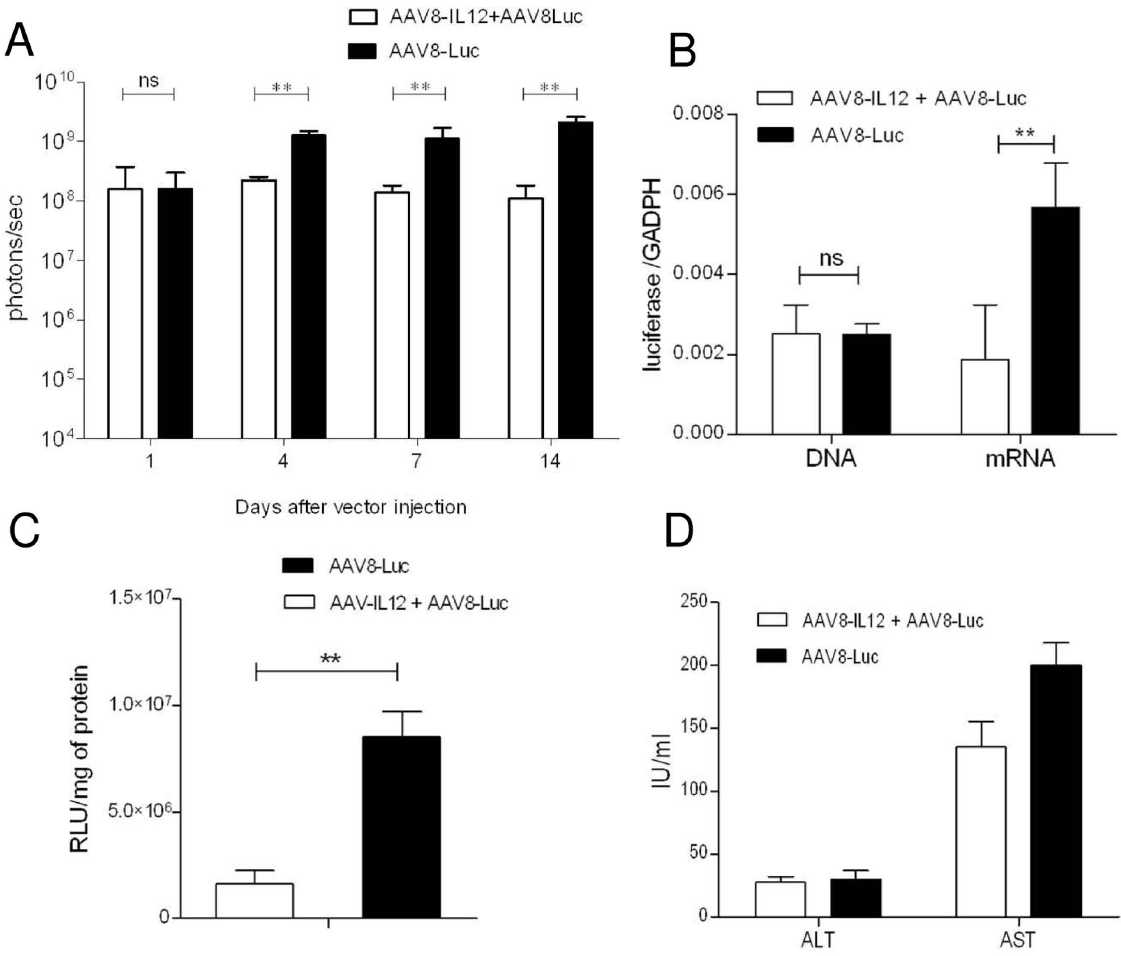
Figure 2. IL-12 down-regulates AAV mediated gene expression without reducing the number of viral genomes. C57BL/6 mice (n=5) received 2.5 6 1011 vg/kg of AAV8-luc vector alone or in combination with 1.5 6 109 vg/kg of AAV8-IL12 vector. A) Luciferase expression levels were analyzed in both groups of animals at days 1, 4, 7, and 14 using a Xenogen in vivo luminometer. Luciferase expression was quantified and represented as photons/second. The data are shown as mean 6 standard deviation (SD). The differences in luciferase expression were statistically evaluated by Student t test (**p , 0.01). B) Animals were sacrificed at day 14. Total DNA and RNA were isolated from liver and vector genome copies and luciferase messenger RNA (mRNA) copies were determined using a q-PCR specific for luciferase, normalized to GADPH copy numbers. Values correspond to the mean copy number from five animals. C) The levels of luciferase activity (relative light units, RLUs) were determined in liver homogenates and were normalized to protein content (RLU/mg). The data are shown as mean 6 SEM. D) Serum transaminases were analyzed 14 days after vector injection. The data are shown as mean 6 standard deviation (SD). Each experiment was repeated three times.